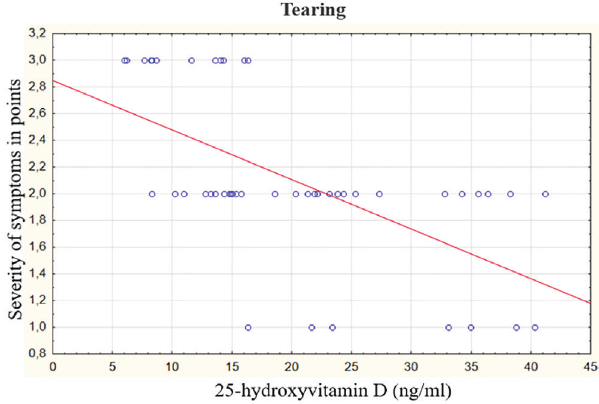
Figure 5e - correlation the itchy eyes with vitamin D concentration Figure 5f - correlation the tearing with vitamin D